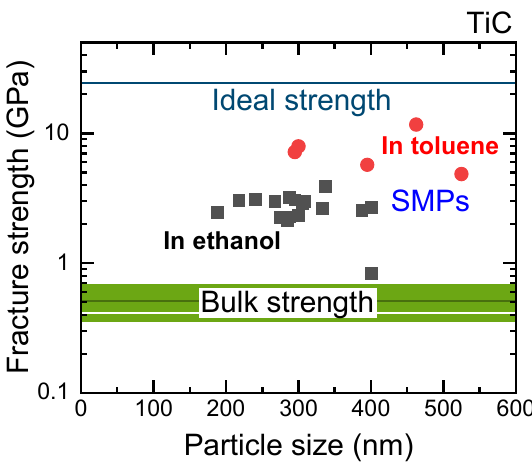
toluene. In relation to bulk fracture strength, TiC SPMs obtained in toluene were greater by Figure 5. Particle size dependence of the fracture strength of TiC SMPs fabricated in ethanol (black one order of magnitude, as in the case of B 4 C [4]. squares) and toluene (red circles). The particles were placed on the SiC substrate and indented by a diamond tip. The calculated ideal tensile strengths and bulk strengths of large compact samples for TiC are also shown.